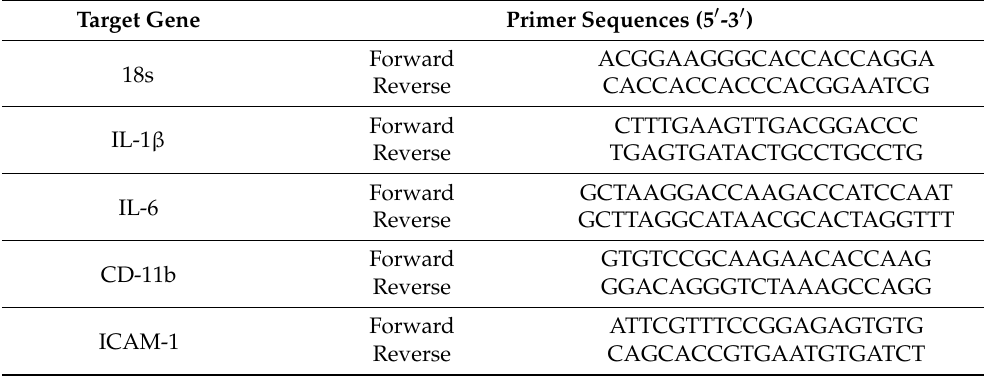
Table 2. Primers used in the qPCR